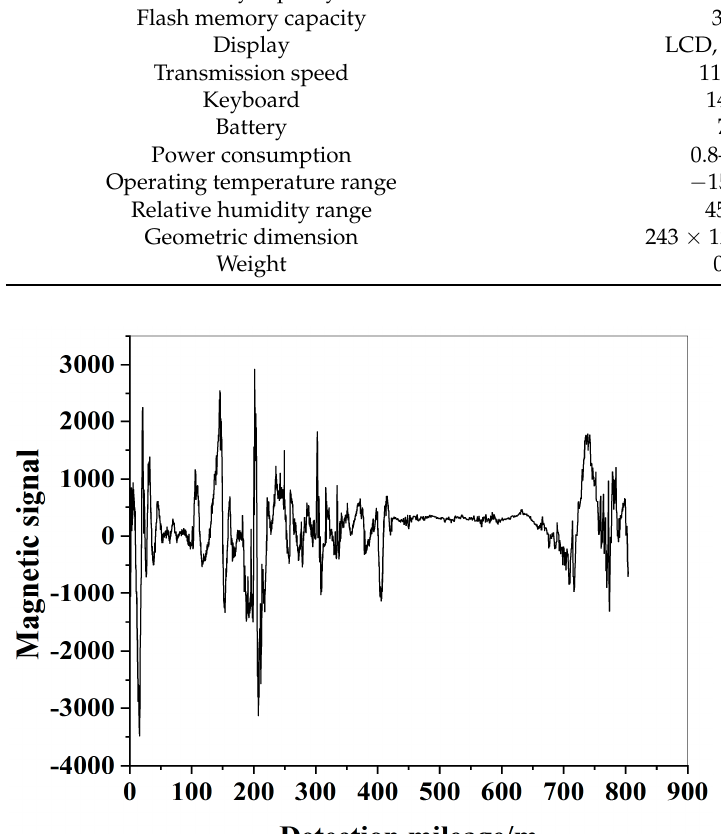
Figure 3. Magnetic signal data of sensor in a 1 z direction.